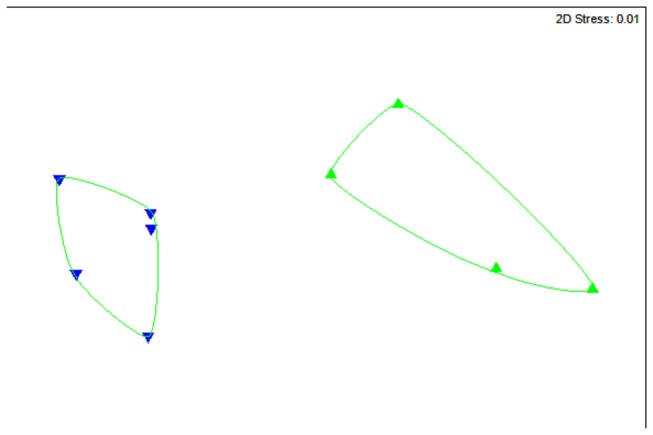
Comparison of hydrocarbon-impacted samples (green) and non-impacted samples (blue).This NMDS ordination is derived from a Bray-Curtis similarity matrix calculated from the square-root transformed abundance of DNA fragments matching the subsystems database, level hierarchical system 1 (BLASTX E-value < E<1×10-5). The light green polygons depict significantly different groupings (P < 0.05) as calculated by similarity profile (SIMPROF) analysis in PRIMER v6. See Table S1 in File S1 for the provenance of samples included in this analysis.